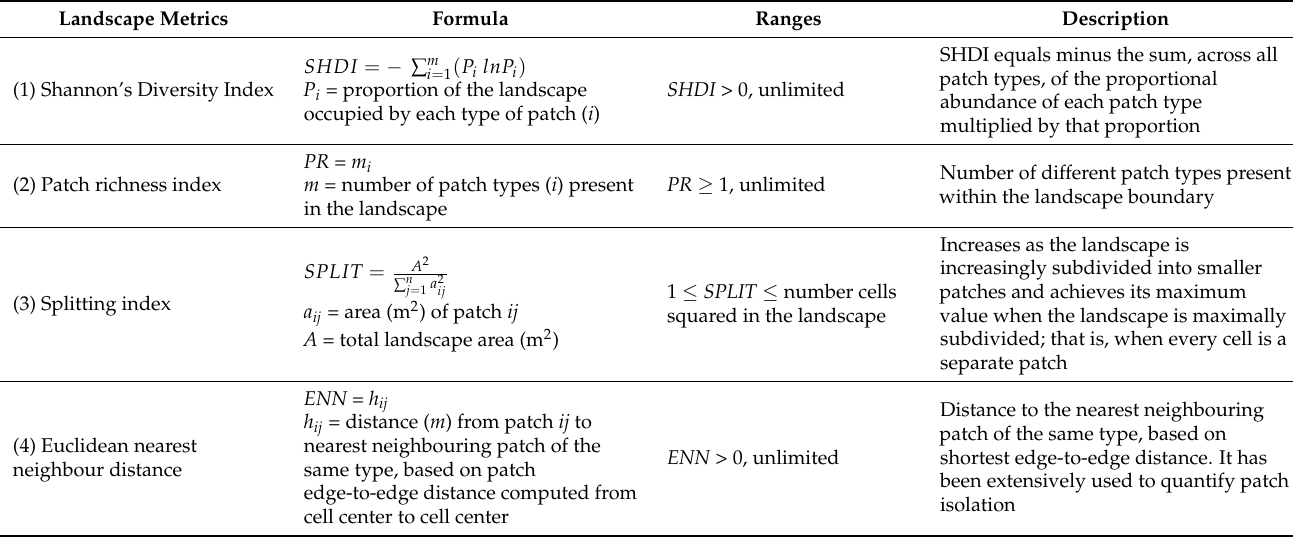
Table 2. Landscape metrics used to calculate landscape spatial patterns. The calculation procedure and a description of each metric are